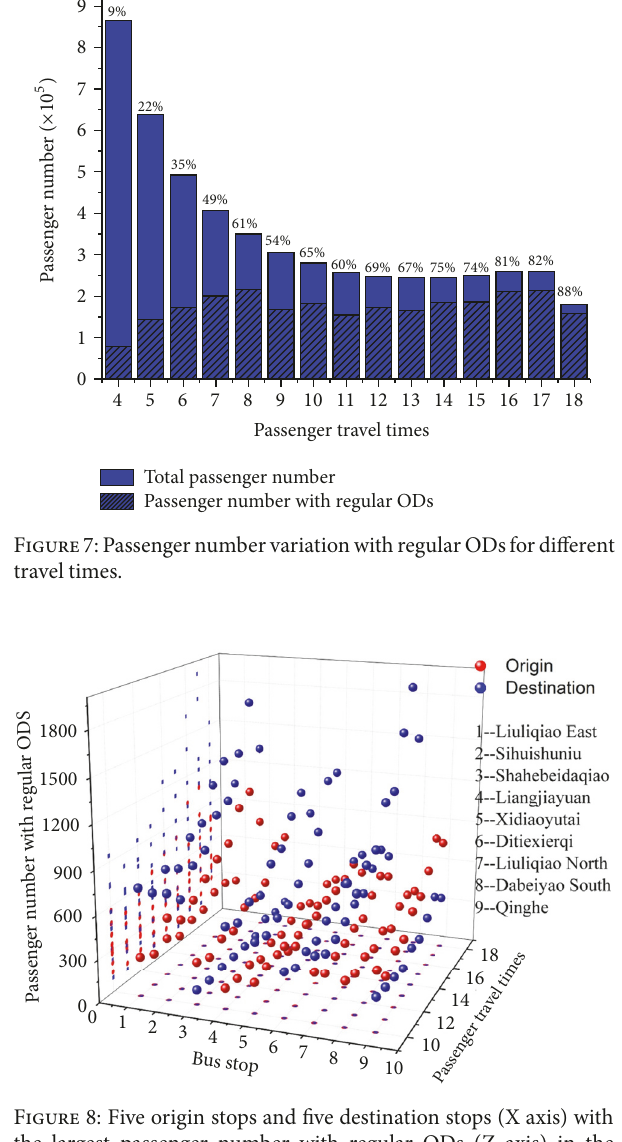
Figure 9 indicates five origin stops and five destination